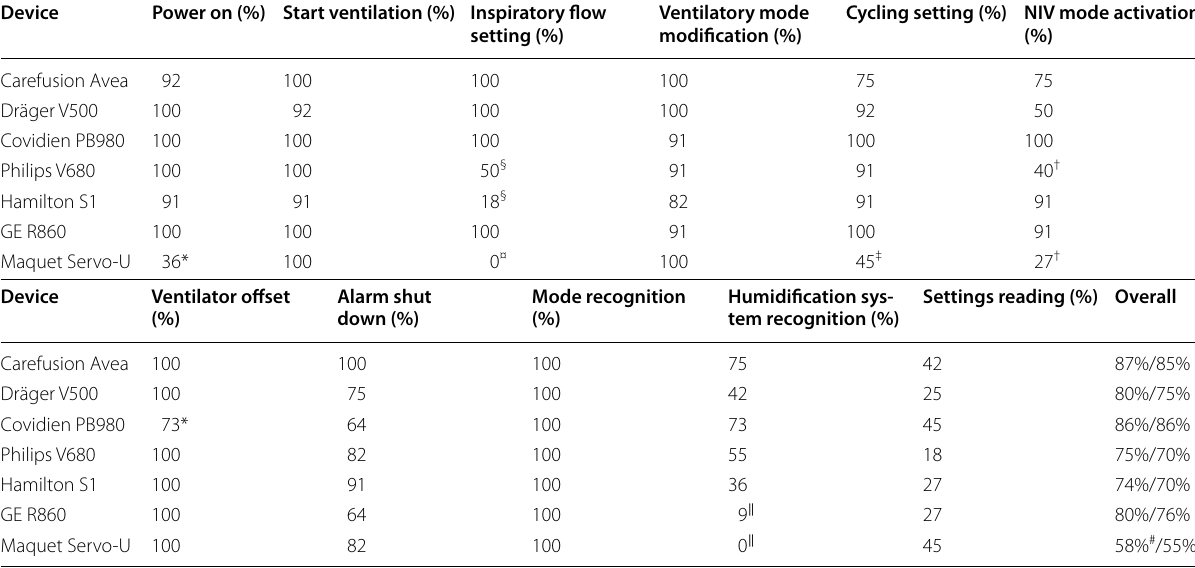
Table 1 Objective tasks completion